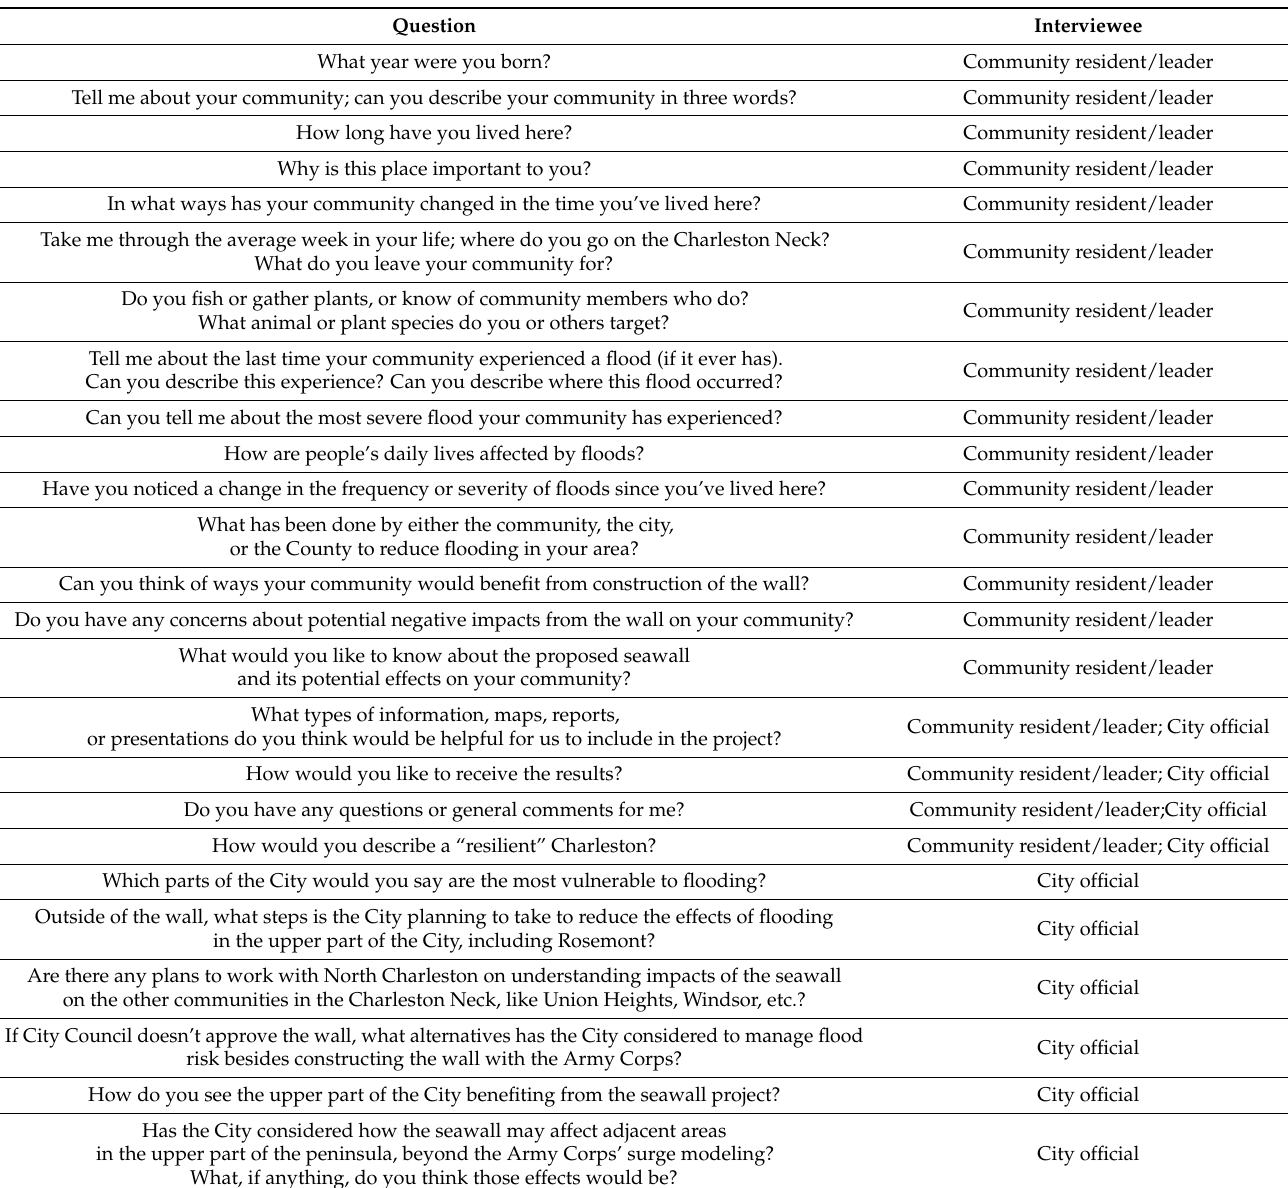
Table 1. List of prepared questions for interviewees.